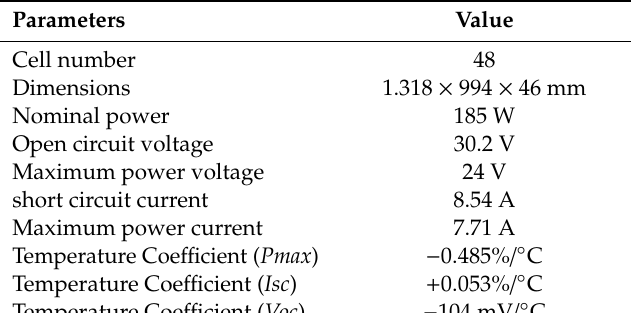
Figure 3. The studied PV array installed at Brunel University London, UK.